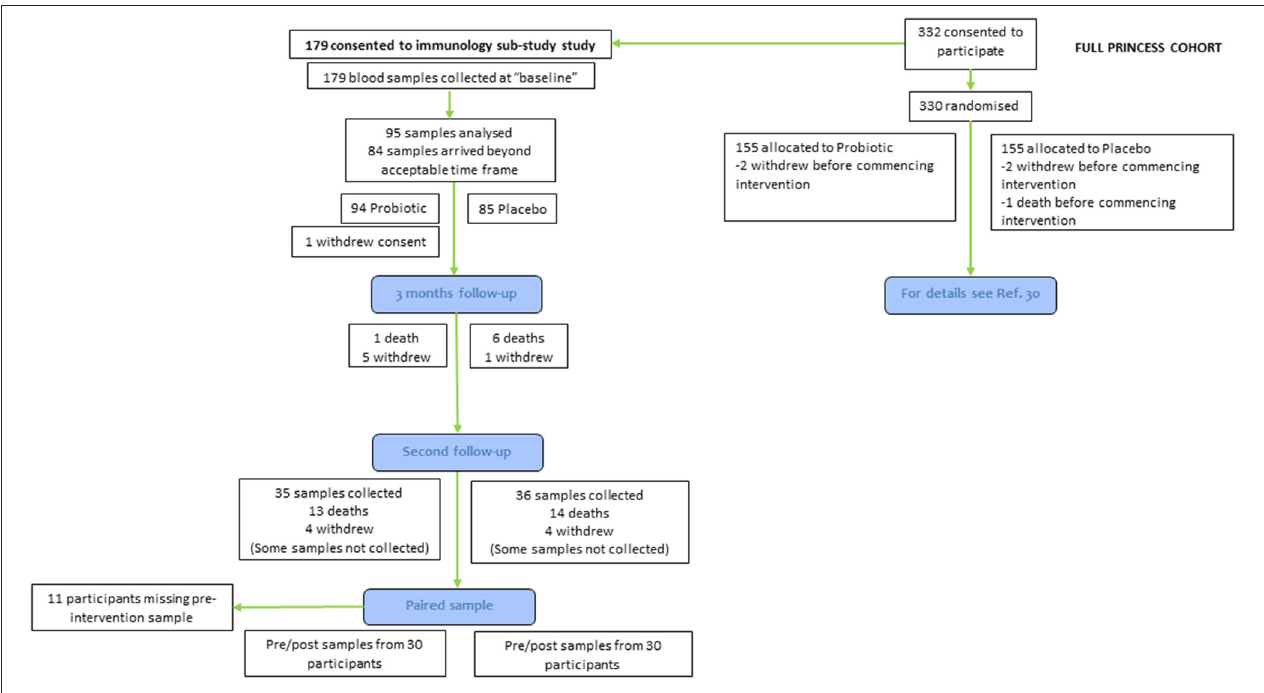
FIGURE 1 | Flow of participants through the